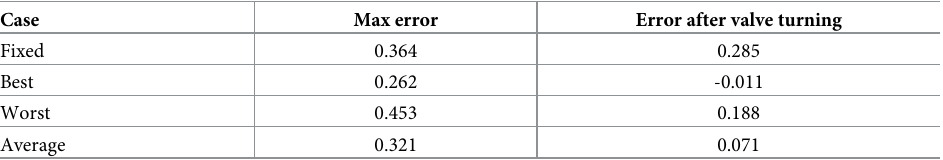
Table 7. Decrease rate of valve angle error between fixed and average